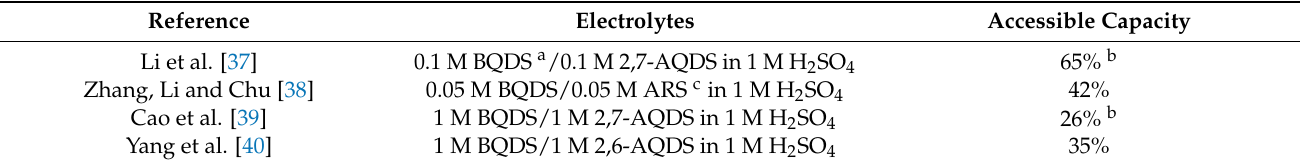
Table 4. Accessible capacity of quinone-based flow batteries in the